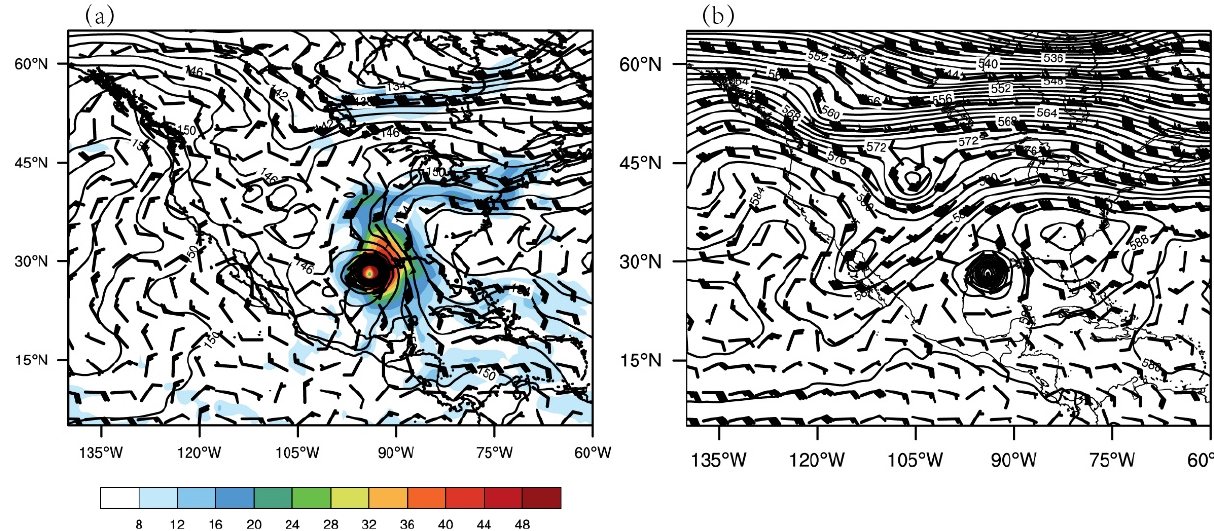
Figure 1. ( a ) Geopotential height (contour, unit: dagpm), wind field (barb, unit: m/s), and water vapor flux (shaded, unit: g/(cm·hPa·s)) at 850 hPa, ( b ) Height field (contour, unit: dagpm) and wind field (barb, unit: m/s) at 500 hPa at 0000 UTC on 13 September 2008.